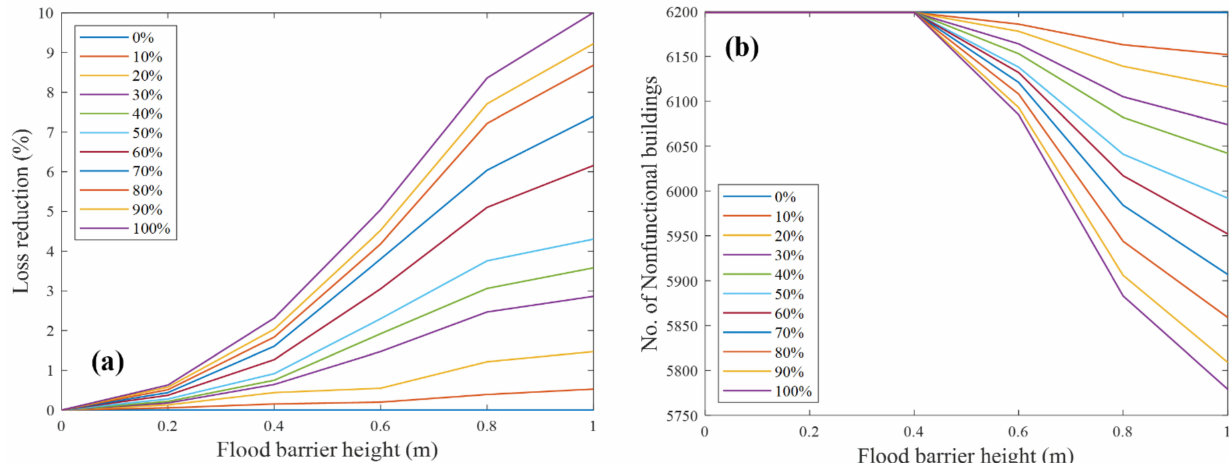
Figure 18. The impact of using flood barriers for commercial buildings only using different barrier height corresponding to each response ratio on: ( a ) The percentage of flood loss reduction; ( b ) The number of nonfunctional